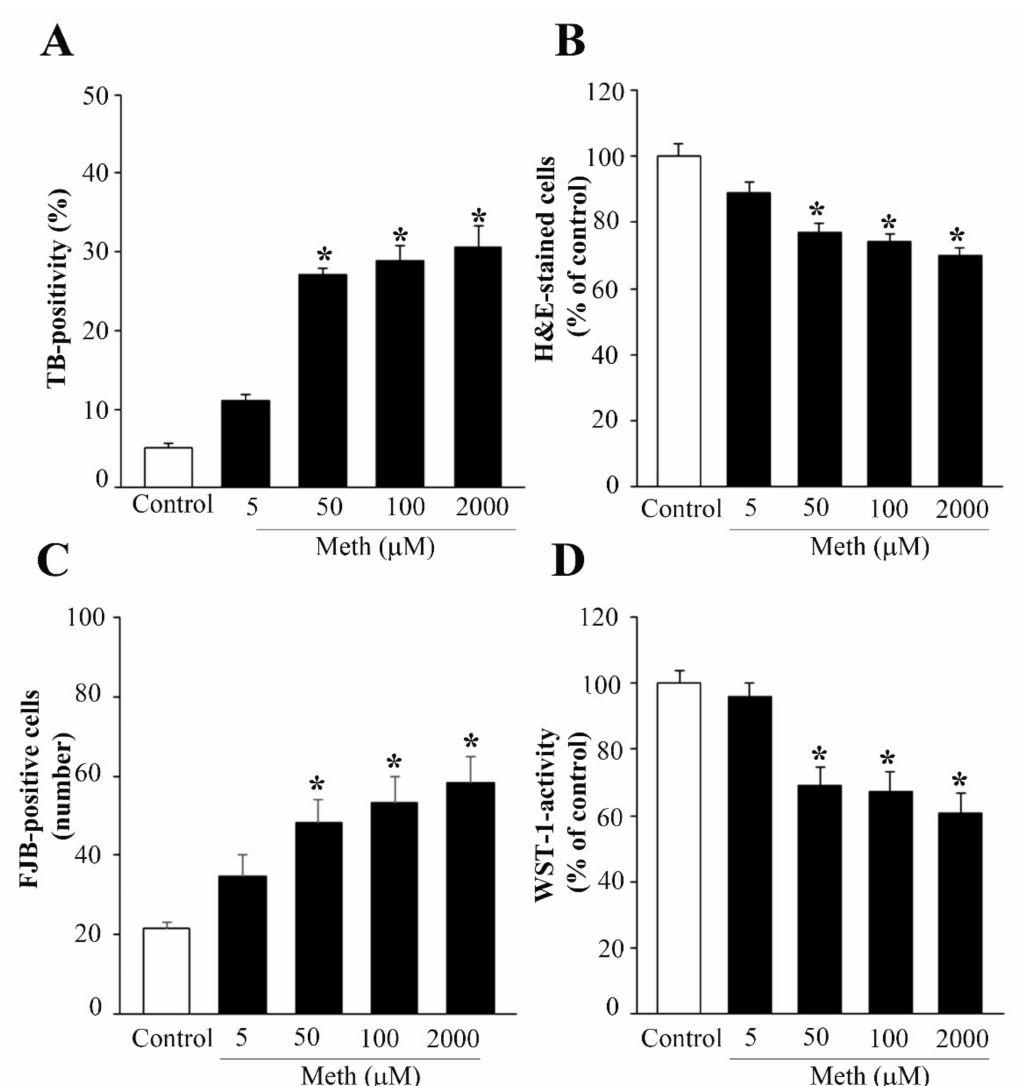
Figure 1. Dose–response curve for Meth-induced toxicity. A wide range of doses of Meth (5 µ M, 50 µ M, 100 µ M, 1 mM, 2 mM) was administered to PC12 cells for 72 h. ( A ) Graph for TB-stained cells; ( B ) graph of H&E-stained cells; ( C ) graph of FJB-stained cells; ( D ) graph of WST-1 viability assay. While the lowest dose of Meth (5 µ M) did not produce any decrease in cell viability compared with controls, Meth administration from the dose of 50 µ M up to the dose of 2 mM produces a significant cell loss compared with controls, which was detected for each staining procedure. In detail, at 50 µ M, the loss of cell viability already reached a plateau, since no further increase in toxicity was observed by using any procedure up to the dose of 2 mM. Data are given as the mean ± SEM of nine independent counts for TB and WST-1, and six independent counts for H&E and FJB. Inferential statistics was carried out with ANOVA with Scheff è ’s post hoc analysis. (DF = 4). * p < 0.05 compared with